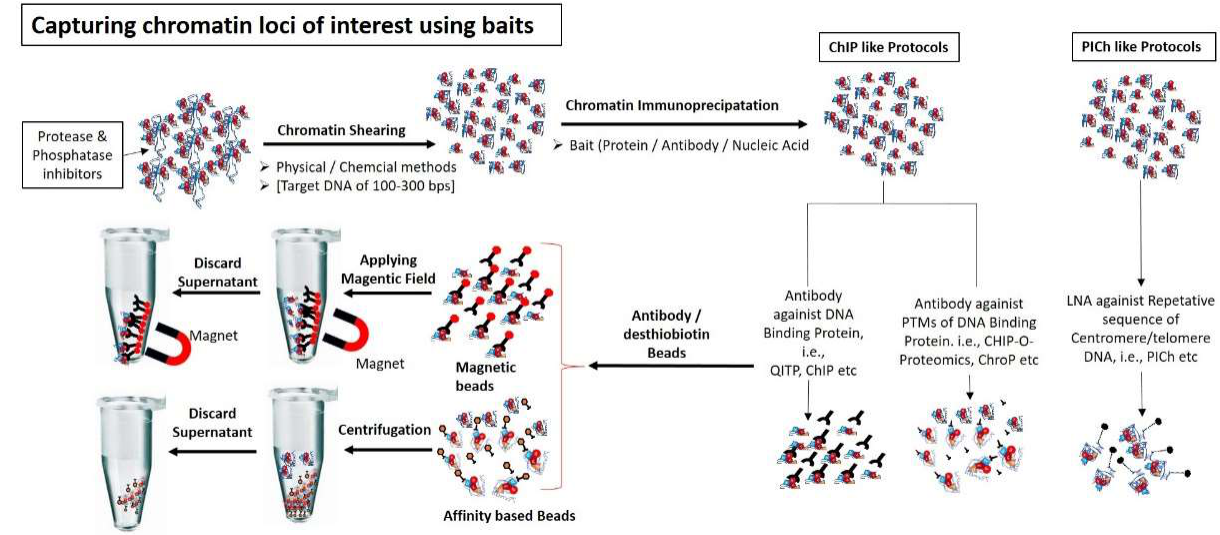
Figure 2. Capturing chromatin loci of interest using different baits: Chromatin are sheared into small fragments (100–300 bps) using either physical methods (i.e., sonication) or chemical method (i.e., Mnase enzyme). Chromatin specific fragments are captured using either protein baits (i.e., antibodies against DNA interacting proteins or against PTMs of interacting proteins) or nucleic acid probe (i.e., LNA, having specific sequence against DNA molecule present in chromatin fragments). Chromatin-bait complexes are precipitated using antibody binding beads (e.g., magnetic or streptavidin beads). Chromatin-antibody-protein beads complexes are washed and separated from non-specific unbound chromatin using magnetic field or appropriate column.